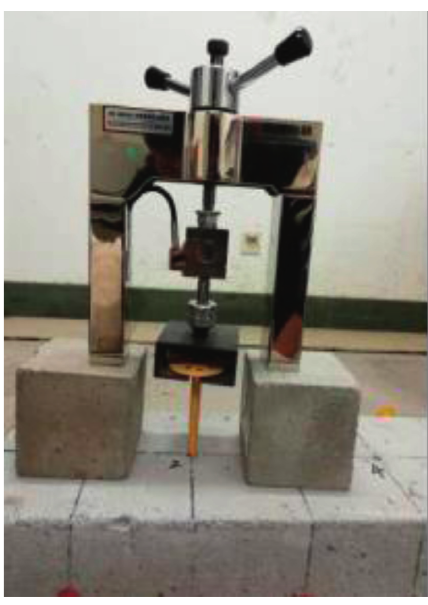
Figure 6: Test loading